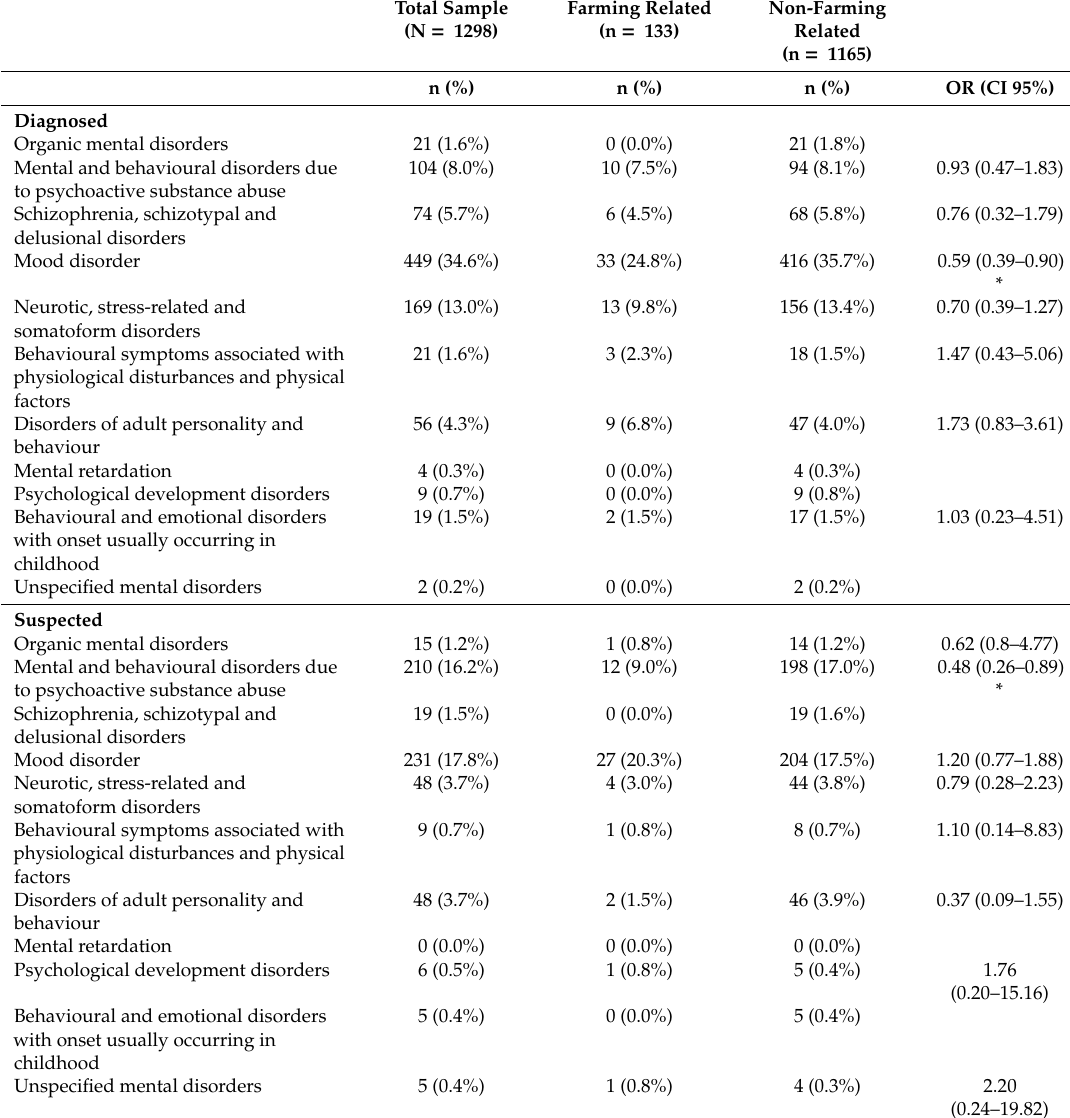
Table 3. Diagnosed and Suspected Mental Health